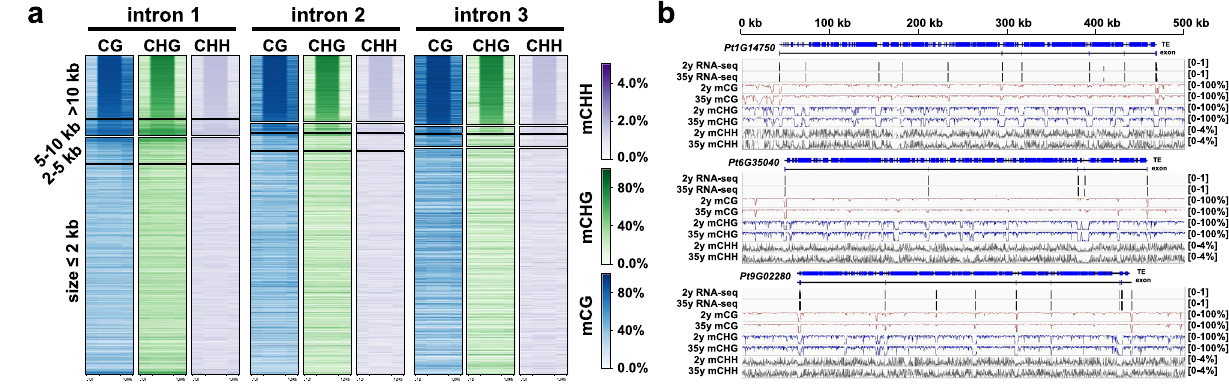
Fig. 3 | Methylation landscapes of ultra-long introns in conifers. a Methylation levelsacrossthe fi rst, second, and thirdintron aswellas fl anking exons ofthe four groups of genes basedon intron length. Intron and exon wereequally dividedinto